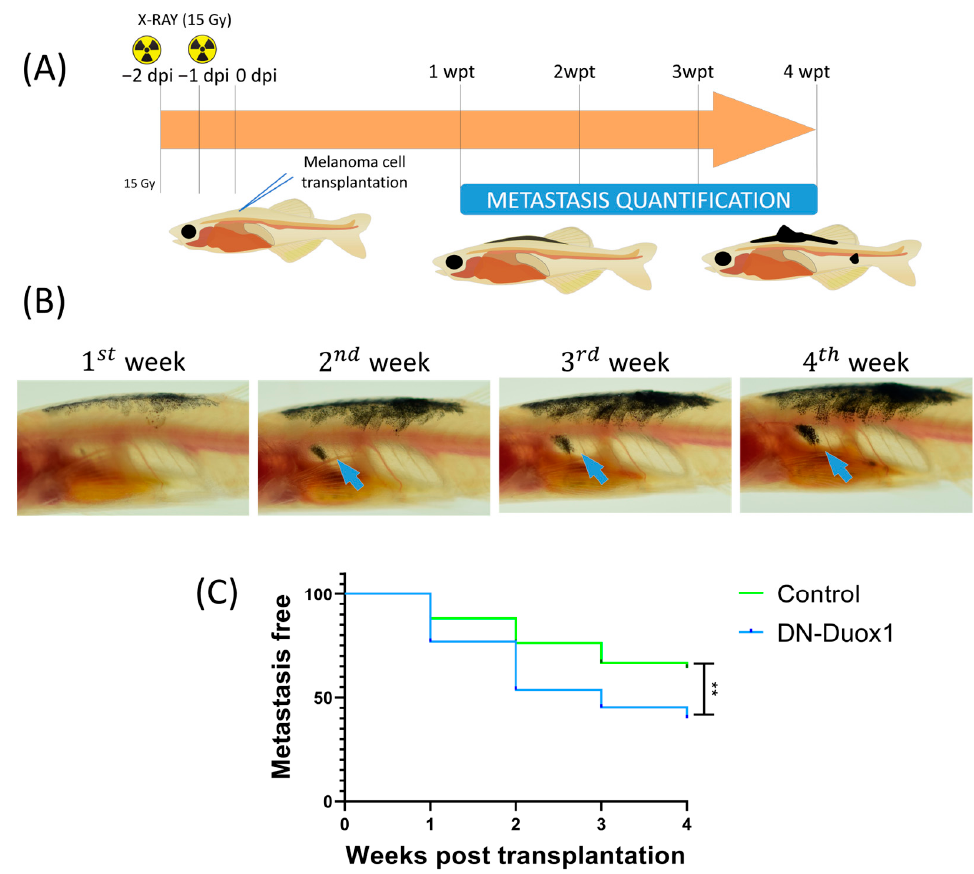
Figure 4. DUOX1 deficiency in SKCM promotes metastasis. ( A ) Schematic diagram of adult allotransplantation assays. ( B ) Representative images of the progression of metastasis (arrows). ( C ) Metastasis-free curve of adult zebrafish transplanted with MinicoopR mitfa:NRAS-Q61R / mitfa:DN-DUOX1 and MinicoopR mitfa:NRAS-Q61R / mitfa:EGFP (control). ** p < 0.01 according to a Log rank Mantel–Cox test. DN-DUOX1: n = 5 tumors and 111 recipient fish; EGFP: n = 3 tumors and 72 recipient